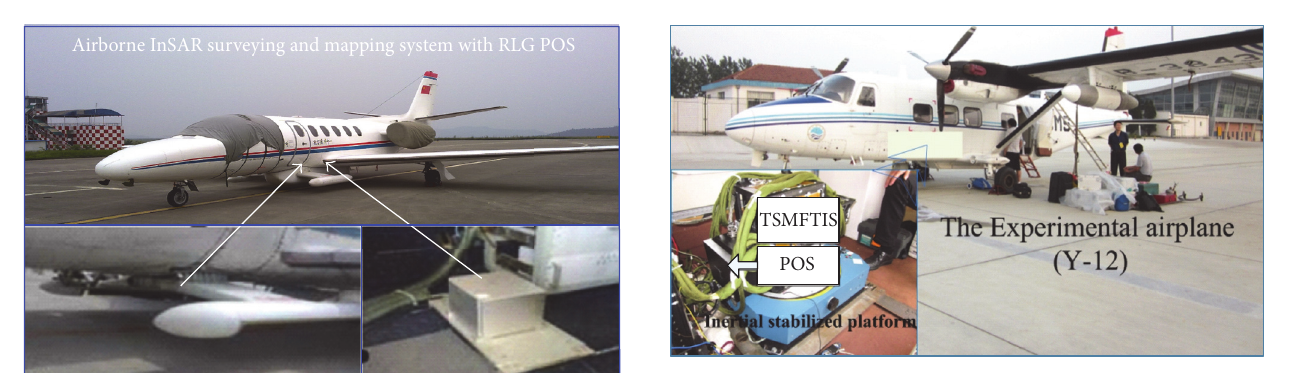
Airborne RLG POSAirborne InSAR Figure 7: The airborne TSMFTIS experiments using POS data. Figure 6: POS applied in motion compensation of airborne InSAR. aerial remote sensing system, and further advance image efficiency and quality of imaging